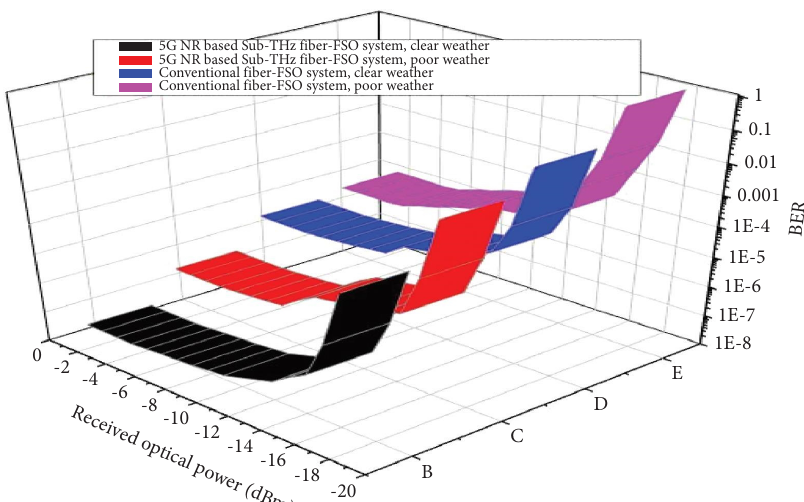
Figure 3: Comparison investigation of presented fber-FSO setup and conventional fber-FSO system using BER and received optical power in dBm.